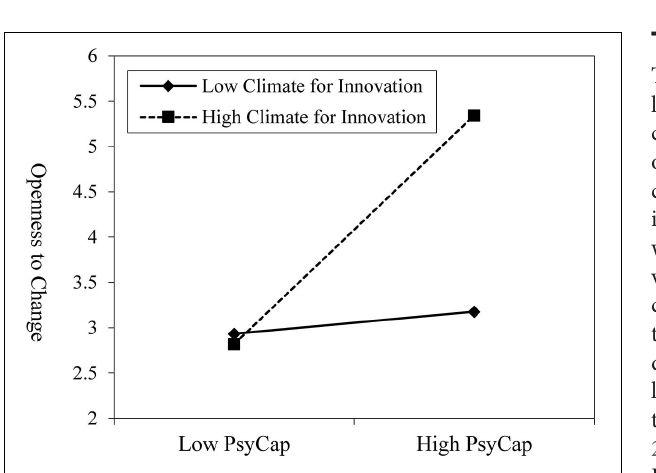
showed that when climate for innovation was high ( b =